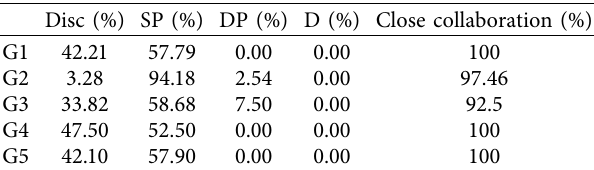
Figure 10: Evolution of collaboration styles over time. Table 3: Proportion of time spent by the five groups on the four collaboration